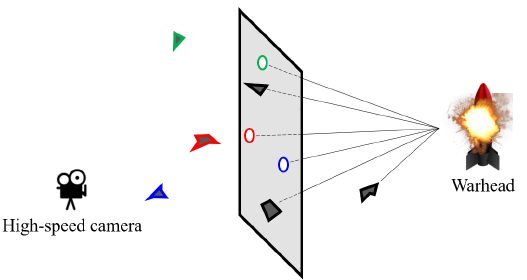
Figure 2. Capturing steel plates with the high-speed camera during a warhead explosion.